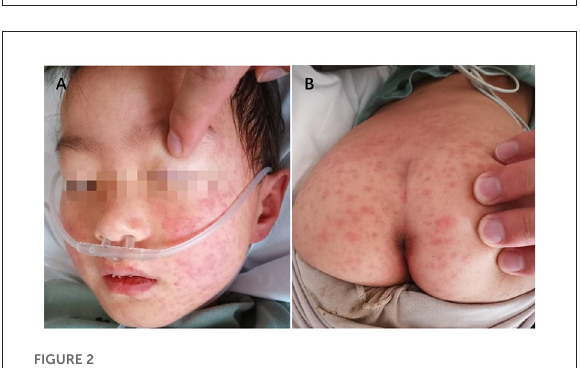
FIGURE2 Pleomorphic rash of face (A) and trunk (B) .